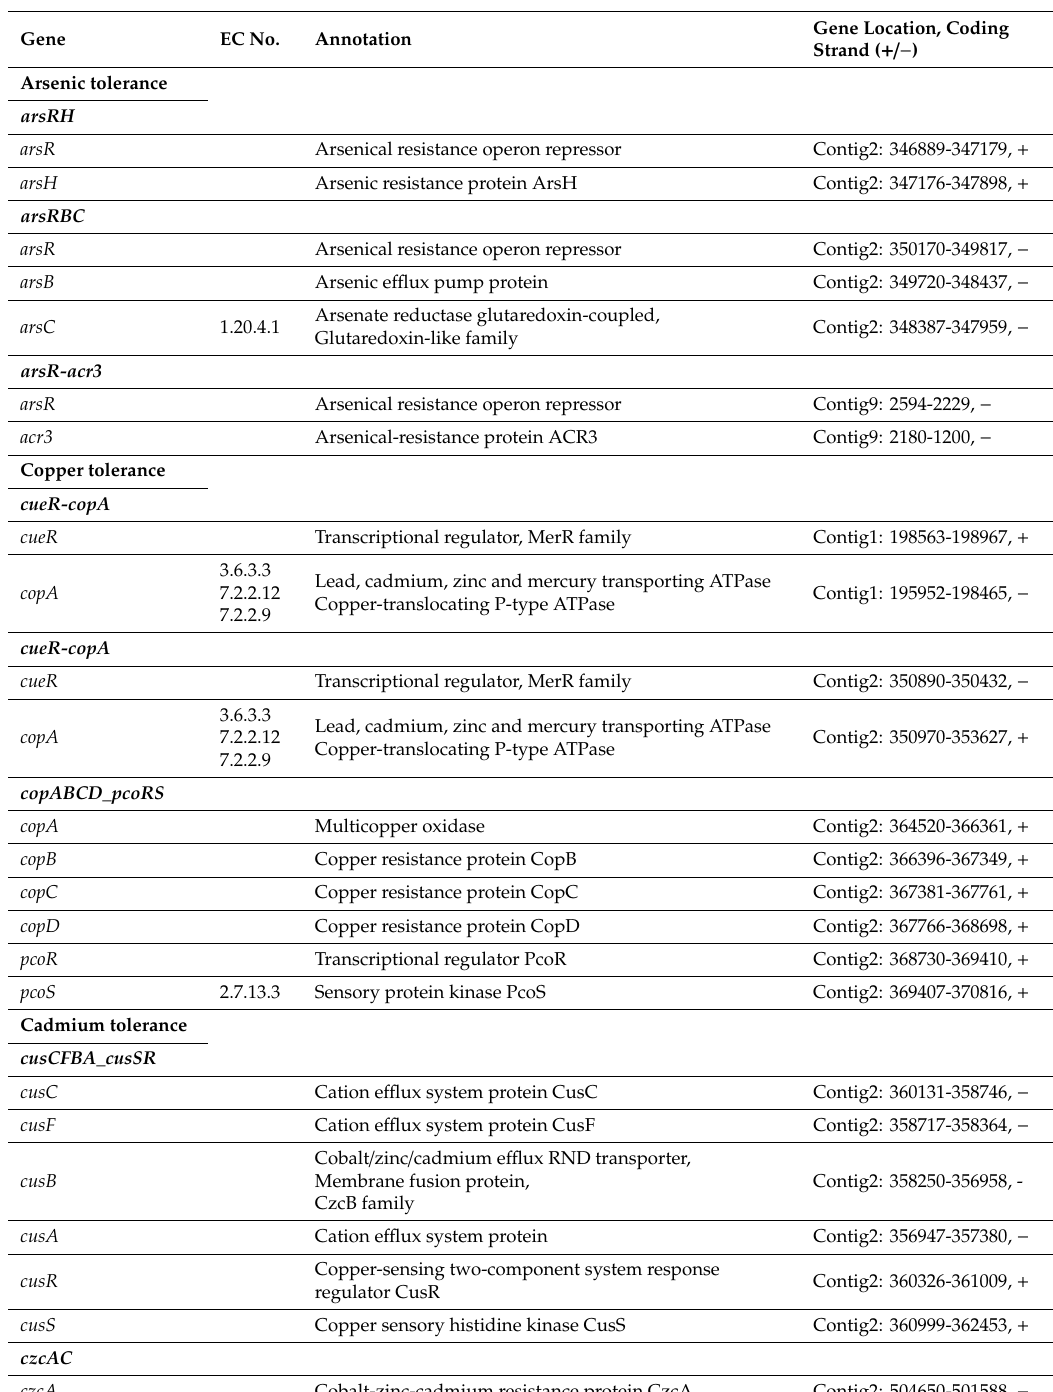
Table 5. Genes for tolerance against heavy metal toxicity in P. agglomerans